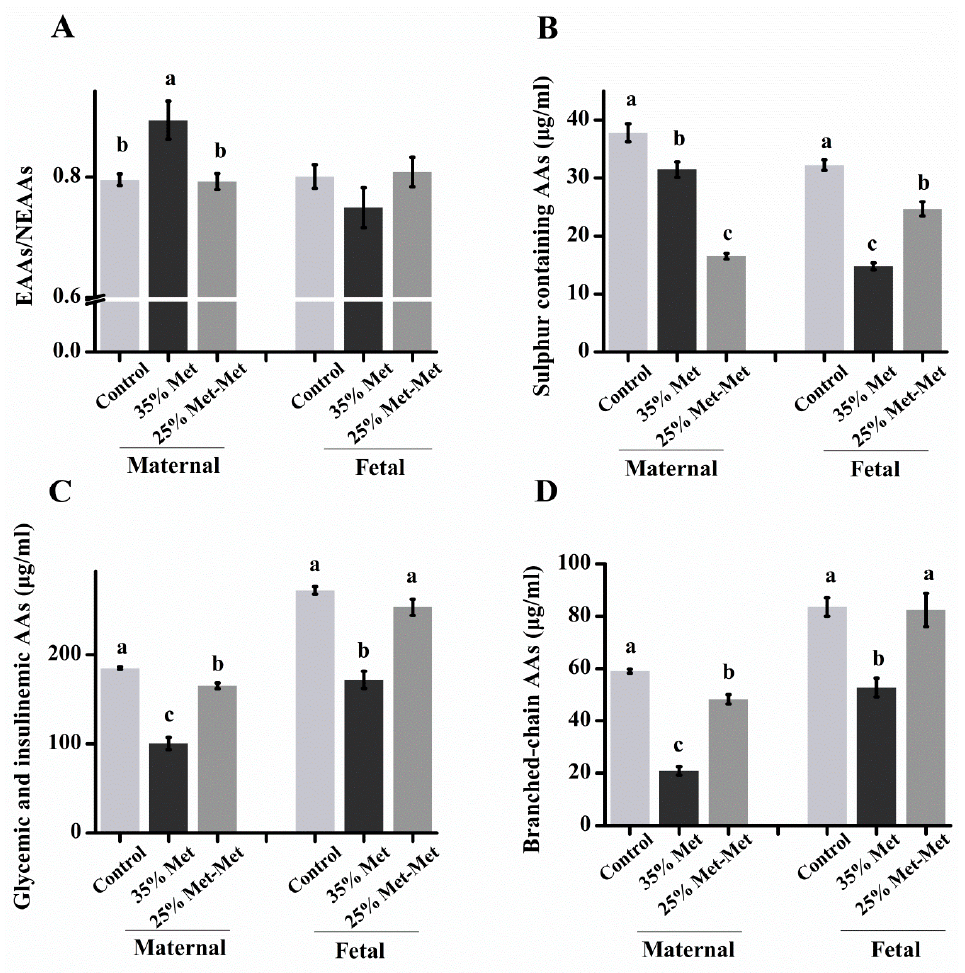
Figure 4. Concentrations of free amino acids (FAAs, µg/mL) in maternal and fetal plasma on day 17 of gestation in mice with different sources of methionine (Met) supplementation. The subfigures are maternal and embryo plasma EAAs/NEAAs ( A ), sulfur-containing AAs ( B ), glycemic and insulinemic AAs and ( C ), and branched-chain AAs ( D ). In the control group, dams were fed a diet supplemented with free Met. In the 35% Met group, dams were fed a Met-removed diet with intraperitoneally injection of 35% of the Met contained in the control diet. The 25% Met-Met group treated was as described for the 35% Met group, except that 25% of the injected Met was replaced with methionyl-methionine (Met-Met). Sulfur-containing AAs: Cys + Met, glycemic and insulinemic AAs: Val + Leu + Ile + Thr + Lys + Arg, and branched-chain AAs: Val + Leu + Ile. The data are expressed as the mean ± SEM, n = 8. The different letters indicate significant differences, p < 0.05.